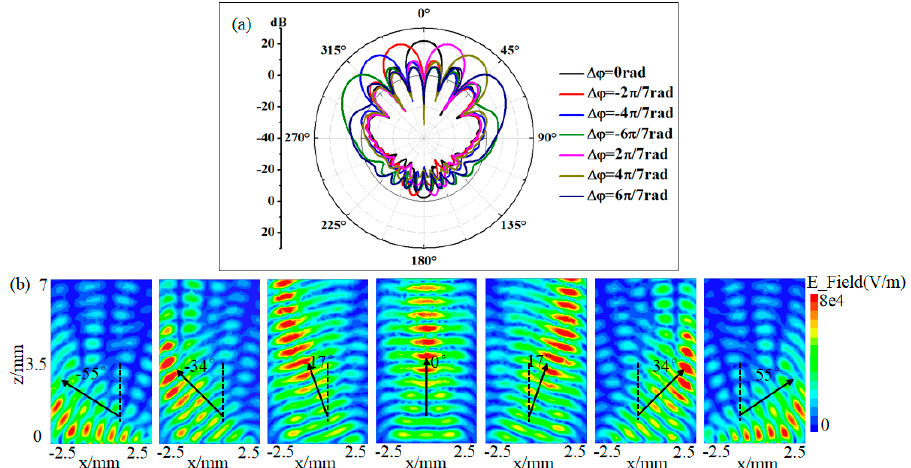
Figure 5. ( a ) Radiation patterns of patch array in the x-z plane with phase gradients of − 6 π /7 (green line), − 4 π /7 (blue line), − 2 π /7 (red line), 0 (black line), 2 π /7 (pink line), 4 π /7 (olive green line), and 6 π /7 (navy line) and ( b ) the corresponding electric field distribution in the x-z plane when the beam steering angle was − 55 ◦ , − 34 ◦ , − 17 ◦ , 0 ◦ , 17 ◦ , 34 ◦ , and 55 ◦ ,